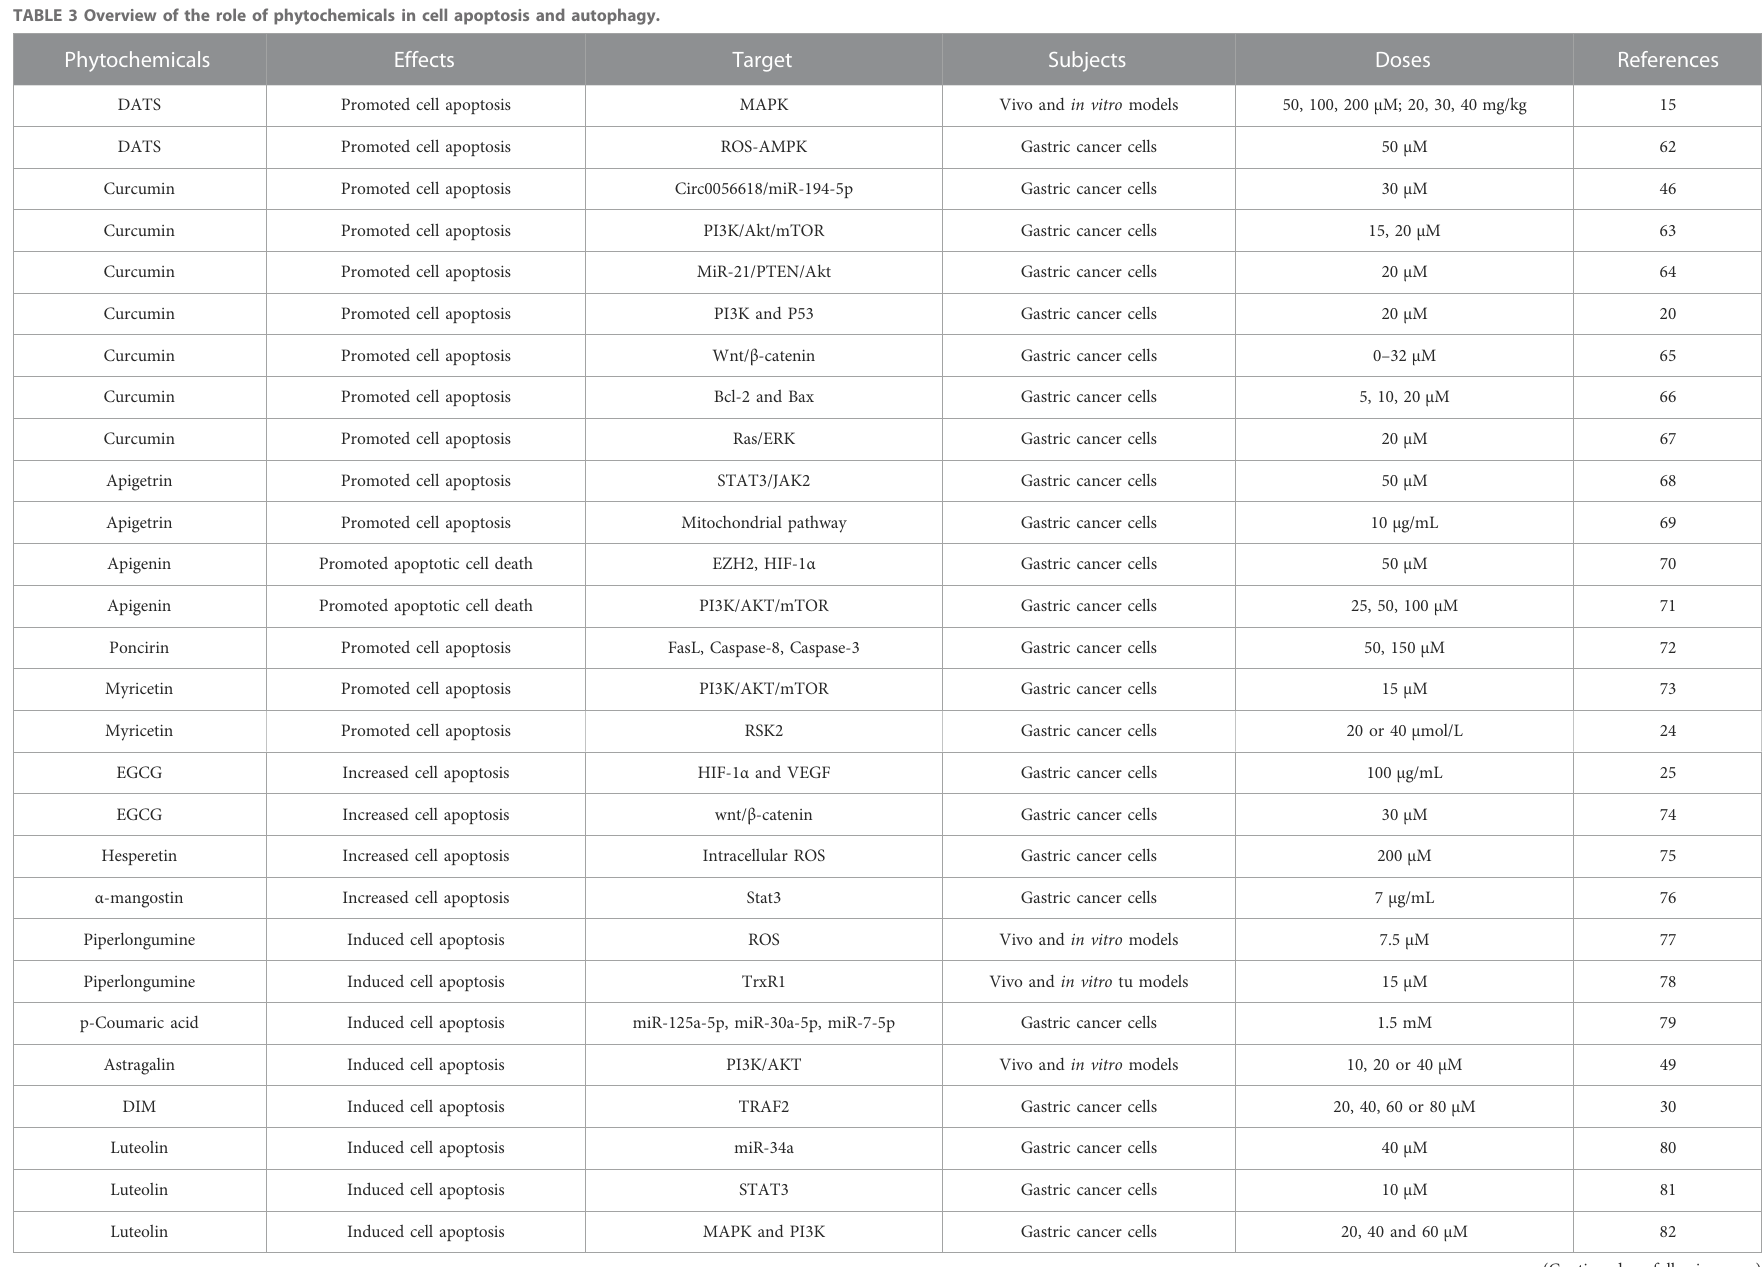
TABLE 3 Overview of the role of phytochemicals in cell apoptosis and